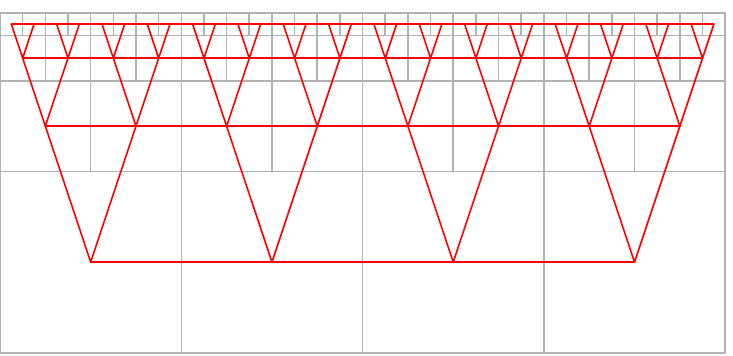
Fig. 14: Dual to B¨or¨oczky